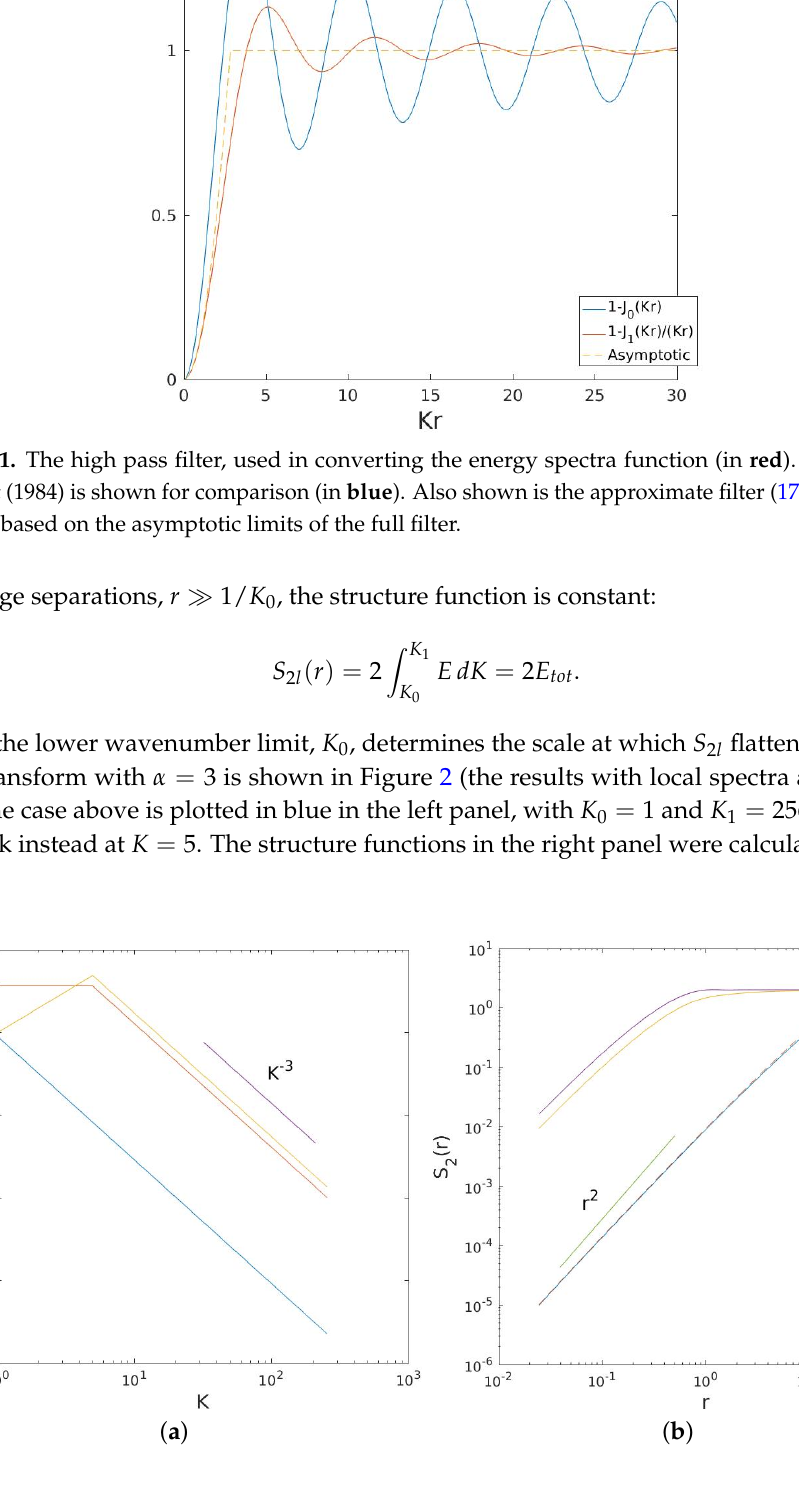
Figure 2. Idealized enstrophy spectra (( a ) panel) and the corresponding second-order structure functions (( b ) panel). The dashed curve in the right panel was calculated using the approximate filter function in (17) and plotted in Figure